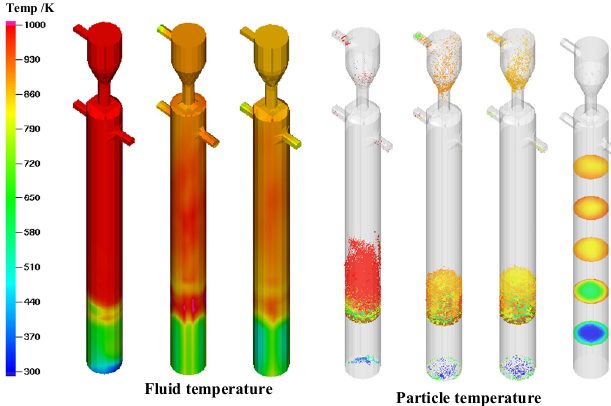
Figure 12. Fluid and particle temperature distributions.